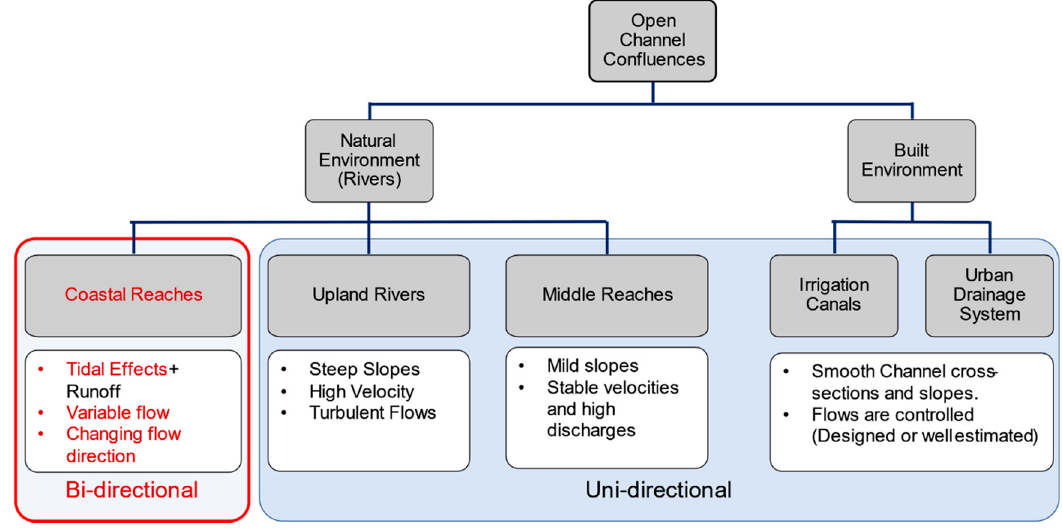
Figure 1. Confluences classification.